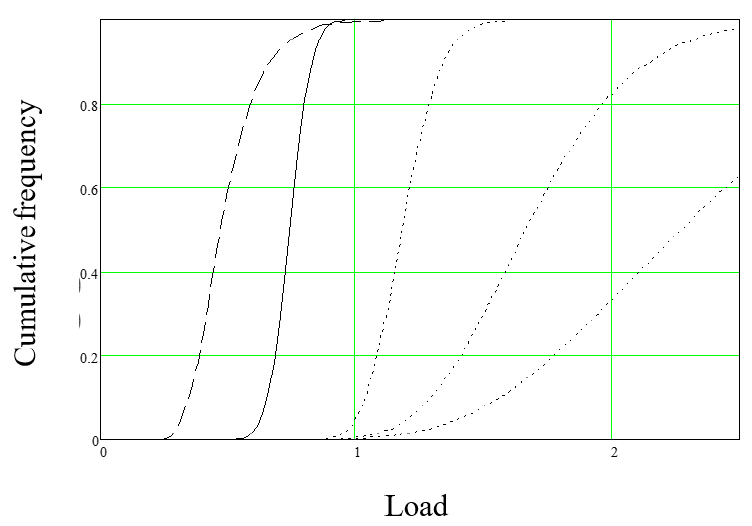
Figure 2. The distributions in the ultimate limit state (ULS), solid line, permanent load, γ G = 1.35; dashed line, variable load, γ Q = 1.5; dotted lines, material property, steel, timber, and concrete, γ M = 1.0, 1.3, 1.4 [13–15].